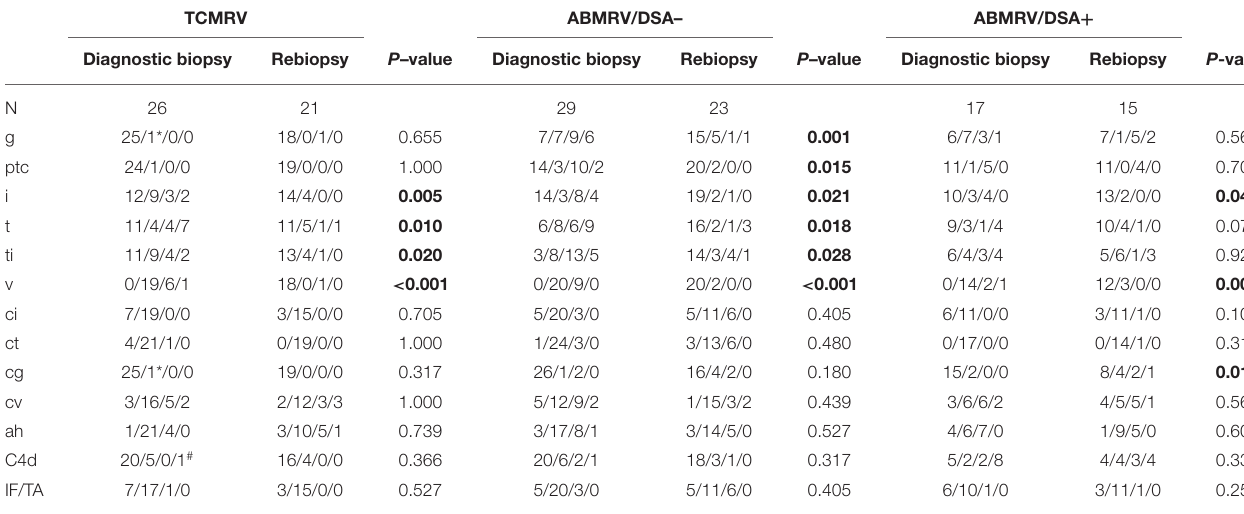
TABLE 3 | Comparison of Banff scores between diagnostic and surveillance biopsies for patients with intimal arteritis.